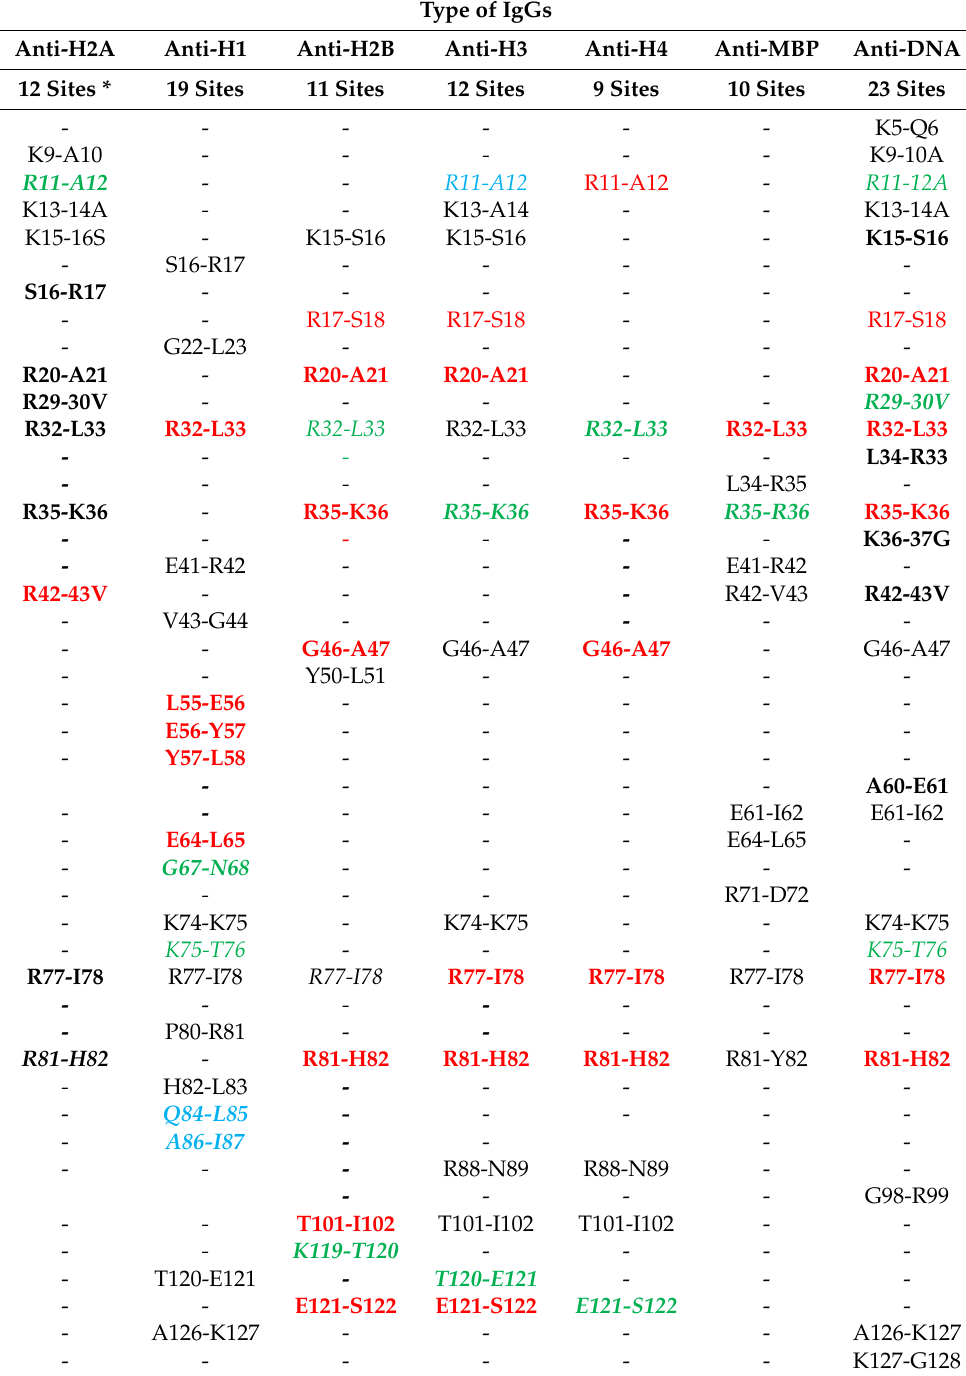
Table 1. Sites of H2A histone hydrolysis by Abs against five histones, MBP, and